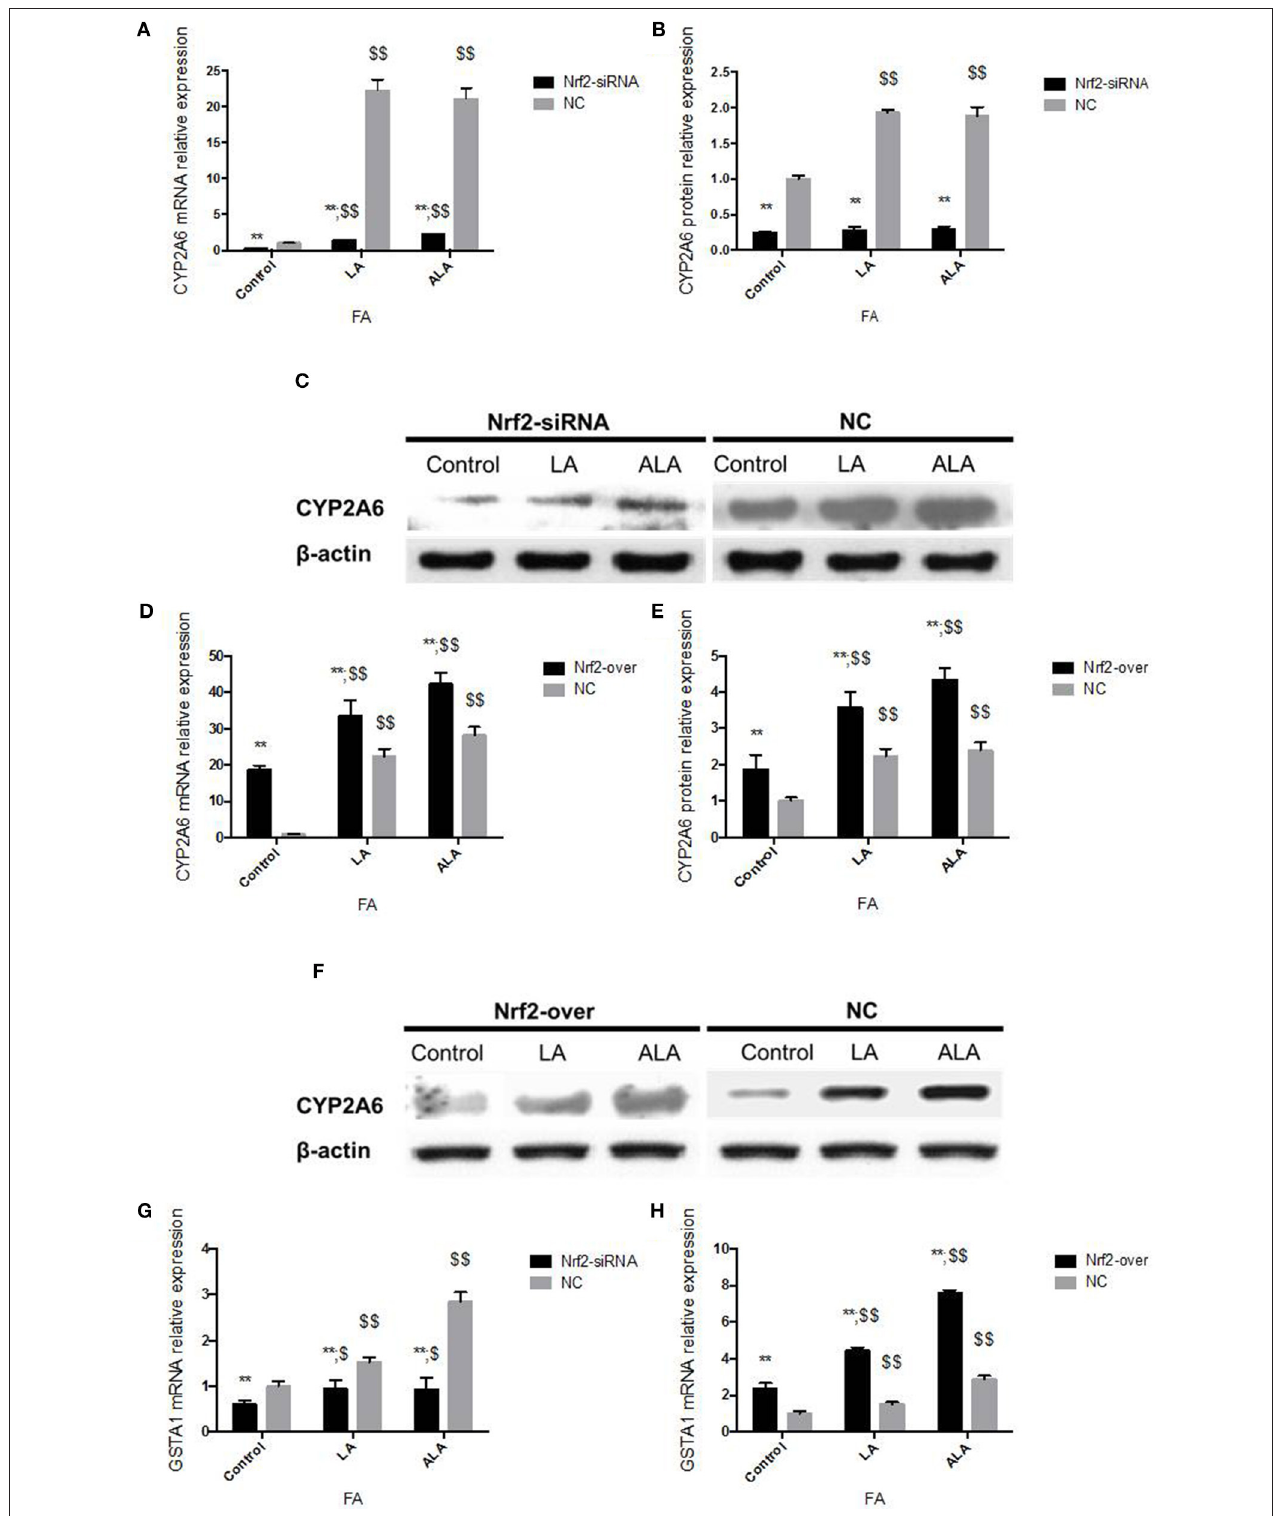
FIGURE 5 | CYP2A6 and GSTA1 expression changes in Nrf2 silenced and over-expressed HepG2 cells administered with LA and ALA. CYP2A6 mRNA (A) and protein (B,C) expressions were both decreased significantly in Nrf2 silenced cells with or without LA and ALA treatment. CYP2A6 mRNA (D) and protein